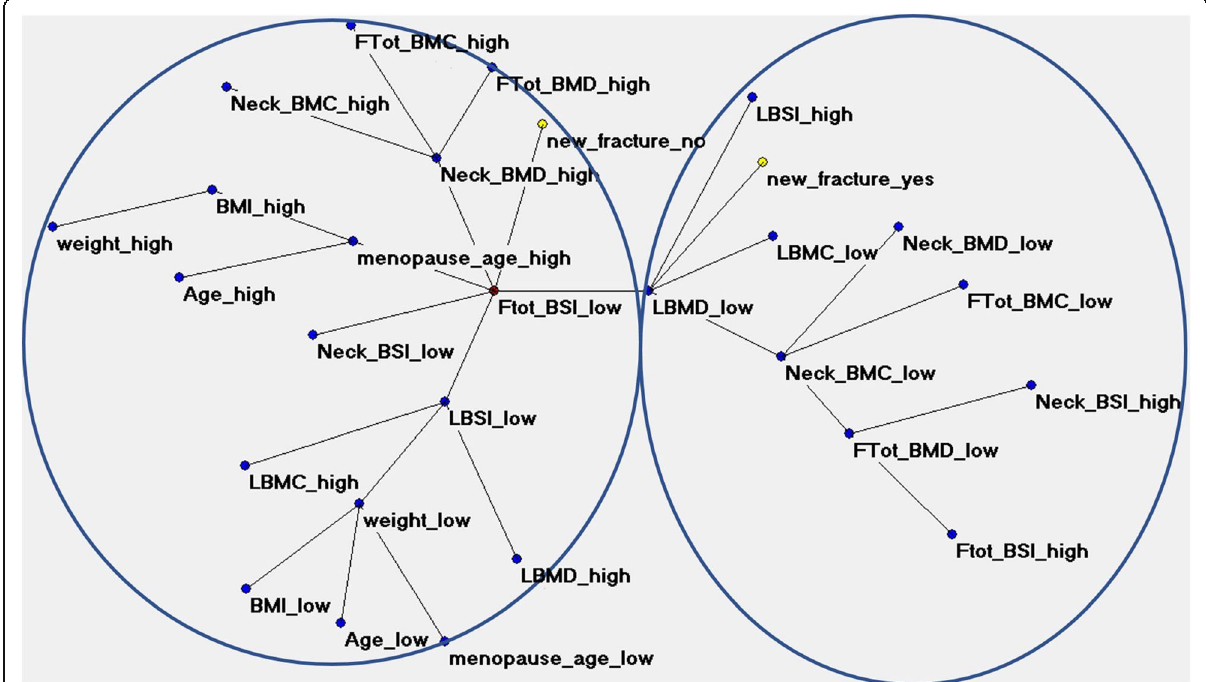
Fig. 4 ANN semantic connectivity developed by Auto-CM system, illustrating the connections among variables in the area without a fracture ( “ new_fracture_no ” , on the left side) and the fractured area ( “ new_fracture_yes ” , on the right side). Ftot, Total femur; BMC, Bone mineral content; BMD, Bone mineral density; BSI, Bone strain index; LBMC, Lumbar BMC; LBMD, Lumbar BMD; LBSI, Lumbar BSI. “ High ” refers to high values, “ low ” refers to low